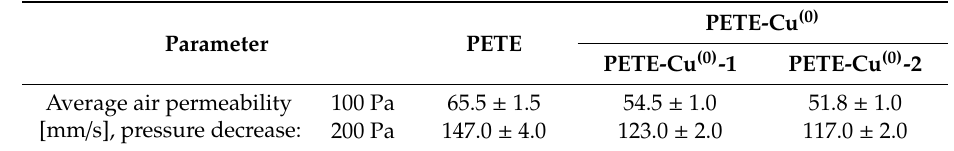
Table 4. The air permeability of the unmodified PETE fabrics and PETE-Cu (0) composites, according to the EN ISO 9237:1998 [115].